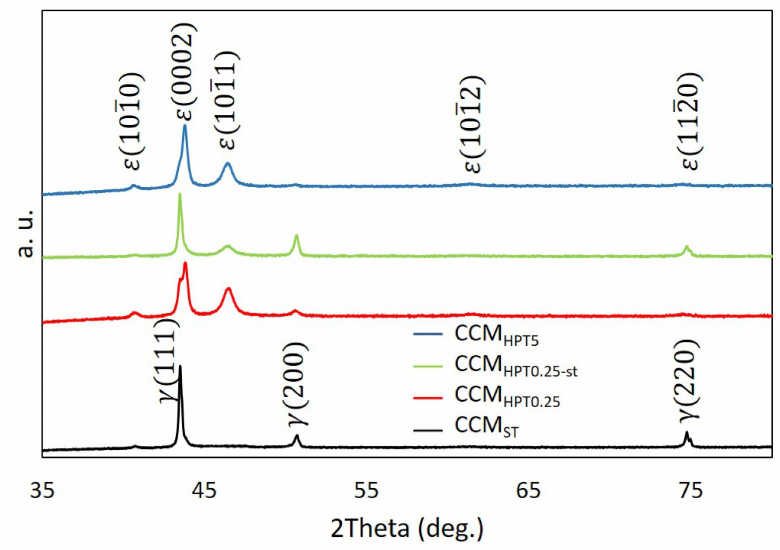
Figure 2. XRD patterns of the initial CCM ST sample and its counterparts of HPT- and post-heat- treated (CCM HPT0.25-st ).